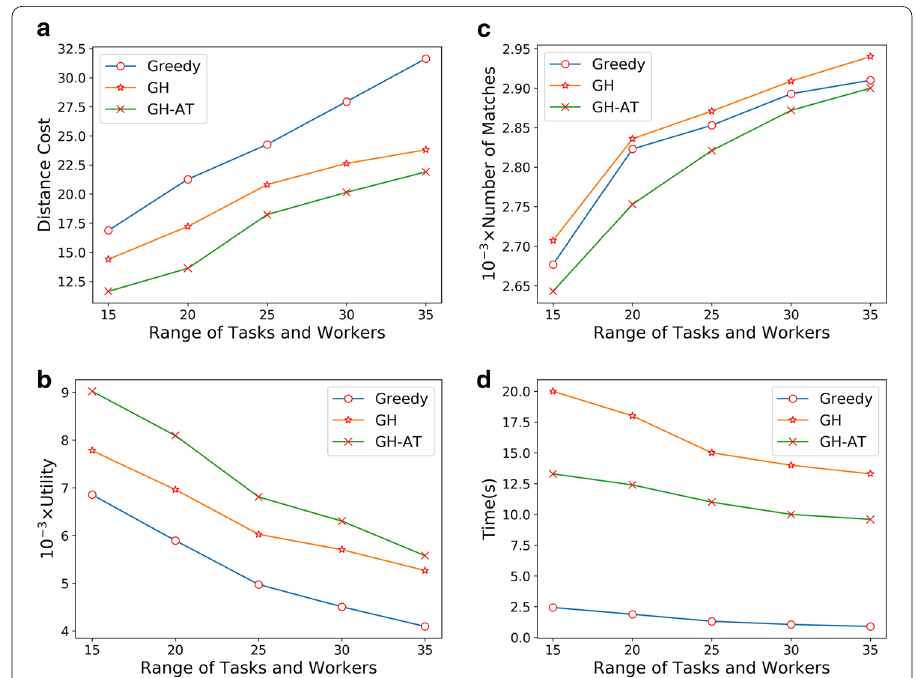
Fig. 6 Varing the range of tasks and